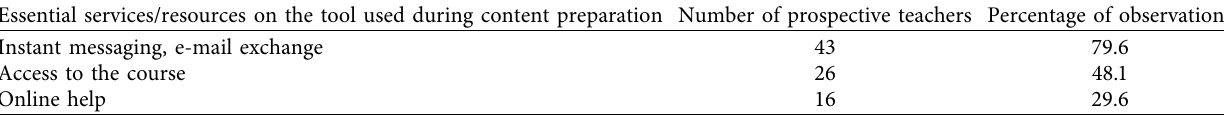
Table 11: Essential services/resources for the tool used during content preparation.